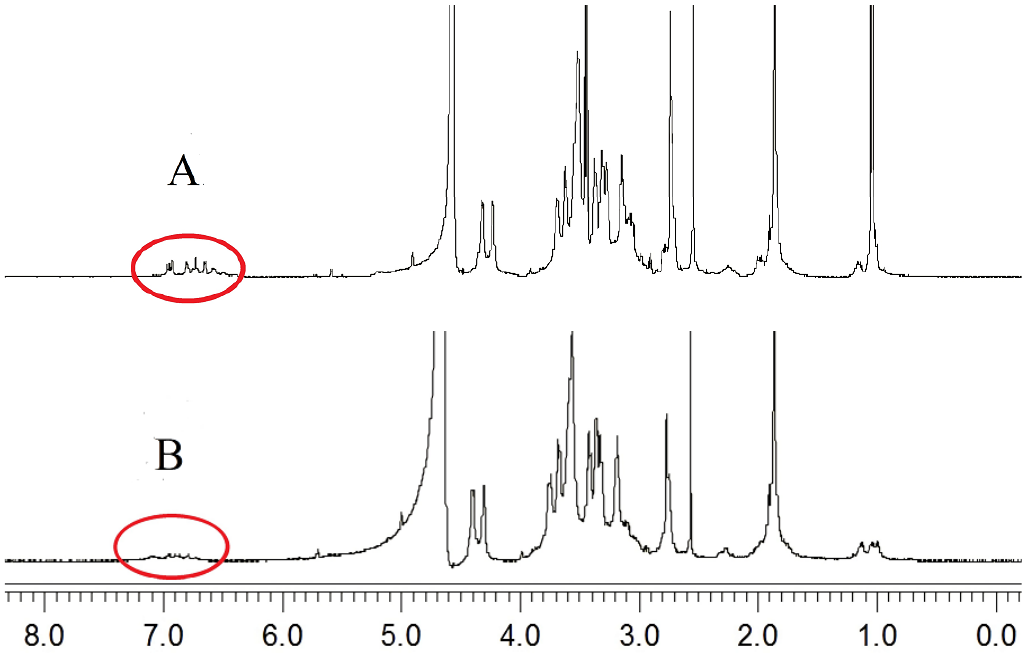
Figure 4. 1 H-NMR spectra of ( A ) HA-DOP and ( B ) HA-DOP-Cu-MP.